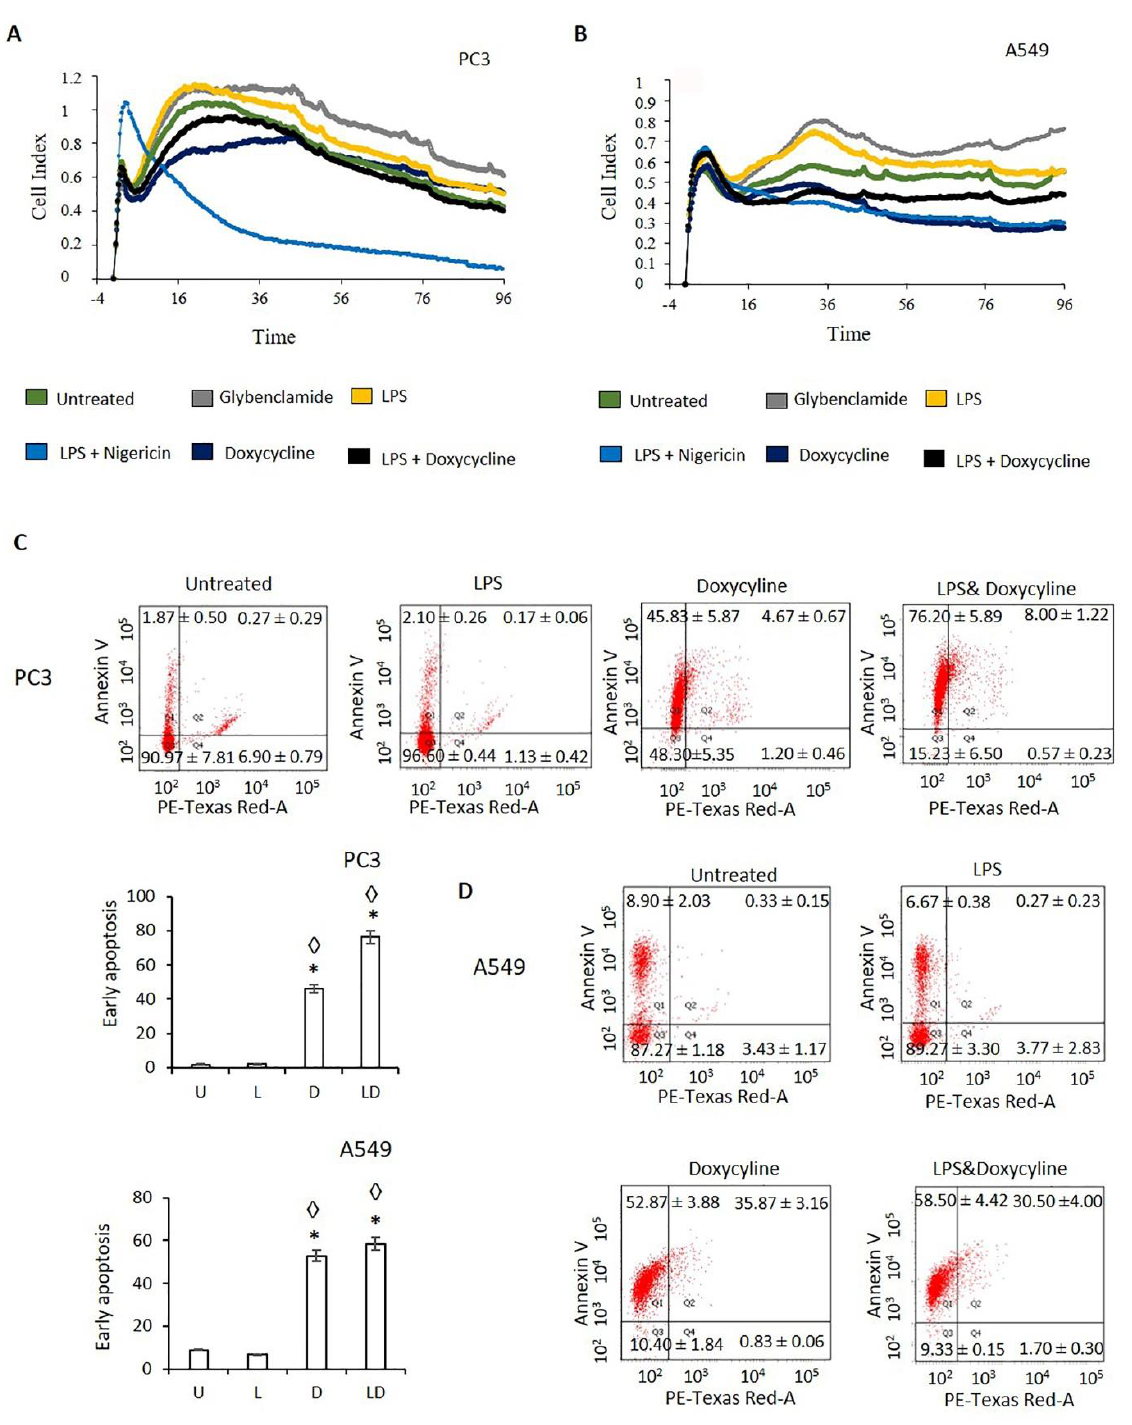
Figure 3. The effect of doxycycline mediated inhibition of NLRP3 on proliferation and viability of cancer cells. ( A ) Doxycycline and LPS-doxycycline effect on PC3 cell proliferation; ( B ) Doxycycline and LPS-doxycycline effect on A549 cell proliferation; ( C ) PC3 cell viability, ( D ) A549 cell viability. The adjusted p-values were calculated using one-way ANOVA and Tukey’s post hoc tests. U: Untreated, L: LPS, D: Doxycycline, LD: LPS-Doxycycline. * p < 0.05 compared to untreated cells ♦ p < 0.05 compared to LPS treated cells; n =